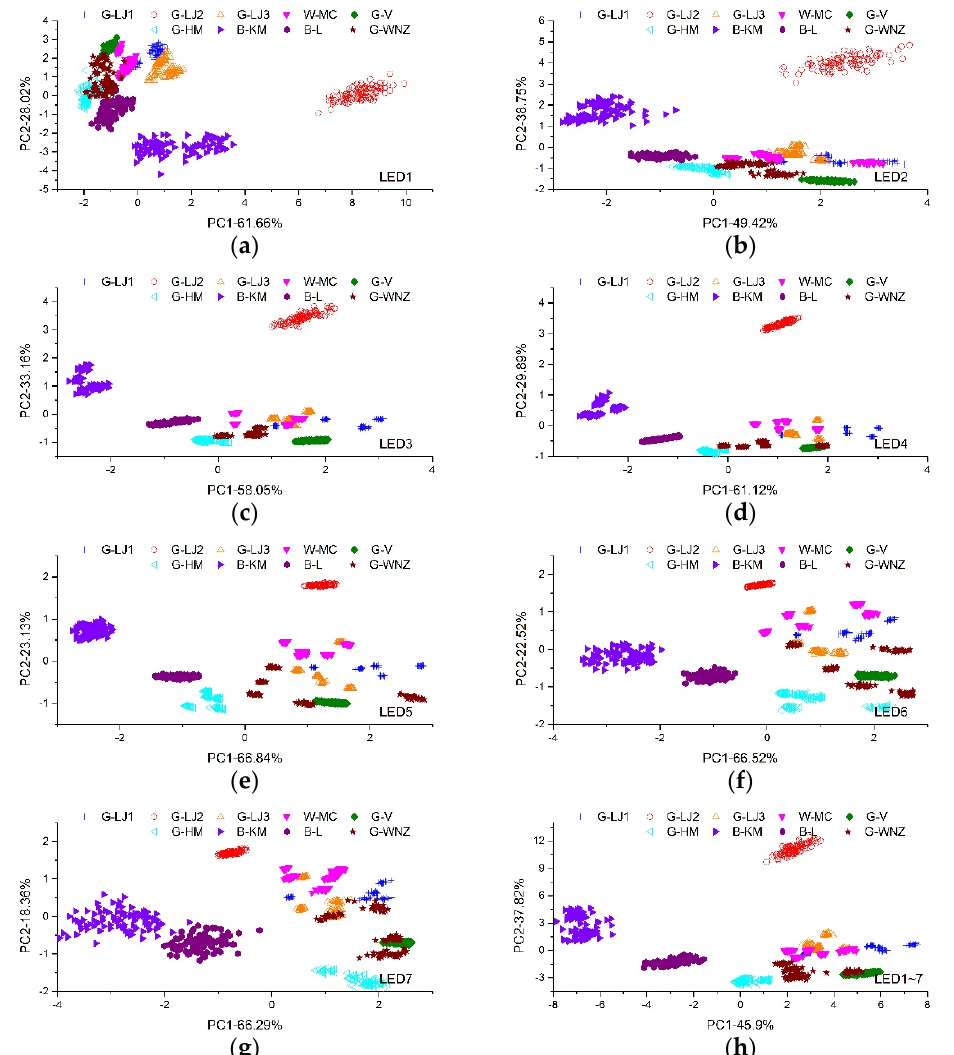
Figure 4. The PCA score plots (PC1×PC2) based on fluorescence spectra of LED1~LED7, respectively ( a – g ) and all spectra ( h ).